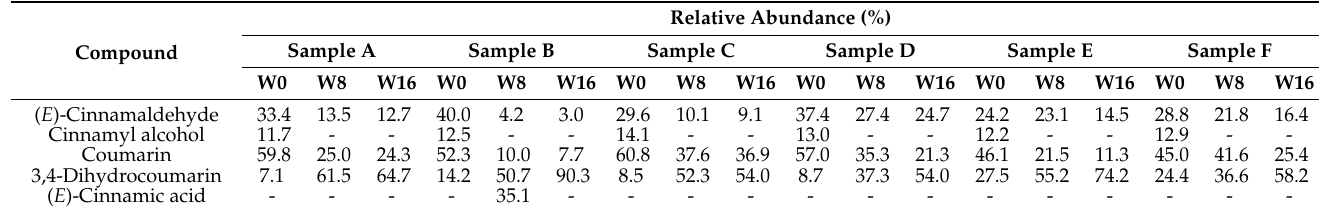
Table 6. Chemical constituent analysis of all stability test samples by GC-MS. Identification was based on their specific m / z values and comparison to literature data and MS database. The details of sample code refer to Table 1. W refers to